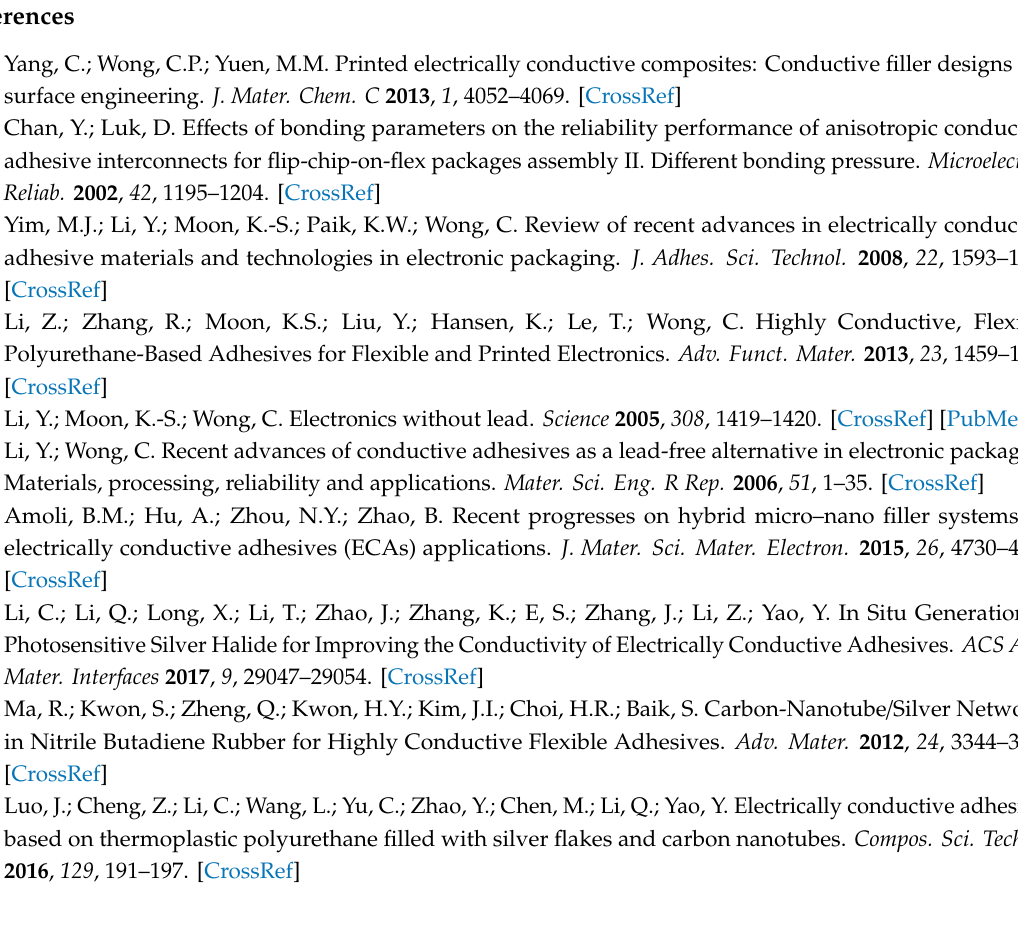
Figure S1: A specialized stretching-system for bending the ECAs sample; Figure S2: The structure of the silver flakes used in this study; Figure S3: Dispersion test of PANI@CNs (1:4) in water and ethanol; Figure S4: The current-voltage curves of the ECAs with di ff erent silver contents; Figure S5: The SEM of high-aspect-ratio PANI@CNs